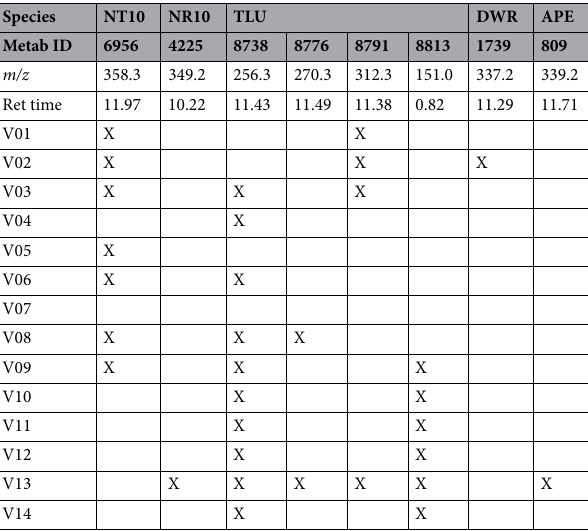
Table 3. List of unique compounds and their occurrence in archaeological